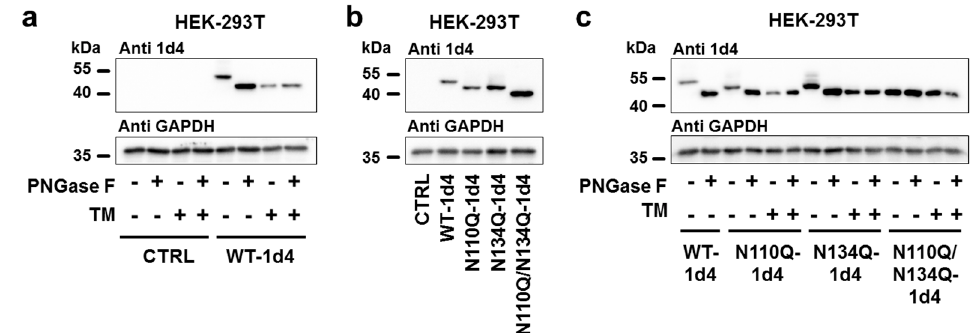
Figure 4. N -glycosylation of hTREK-1 currents, expressed in mammalian cells. To determine whether hTREK-1 channel subunits undergo N -glycosylation in mammalian cells, the relevance of the